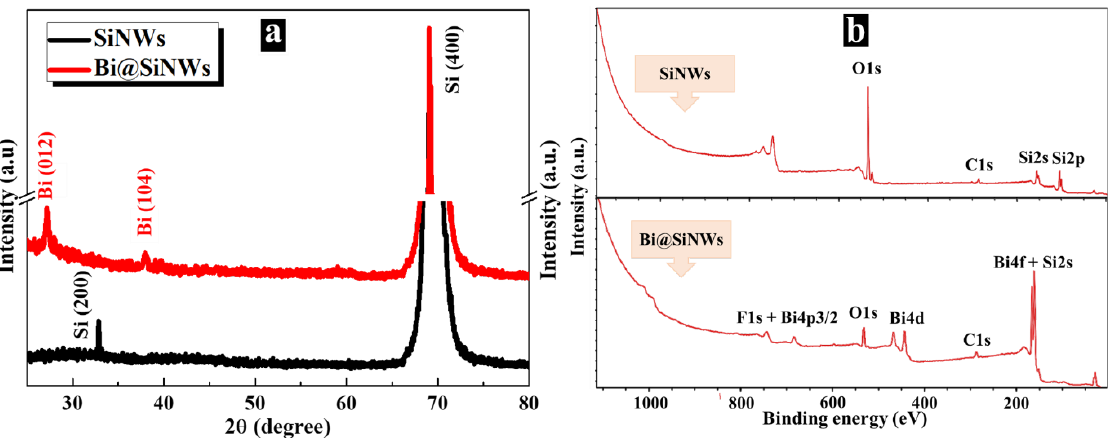
Figure 2. XRD patterns ( a ) and XPS survey spectra ( b ) of SiNWs and